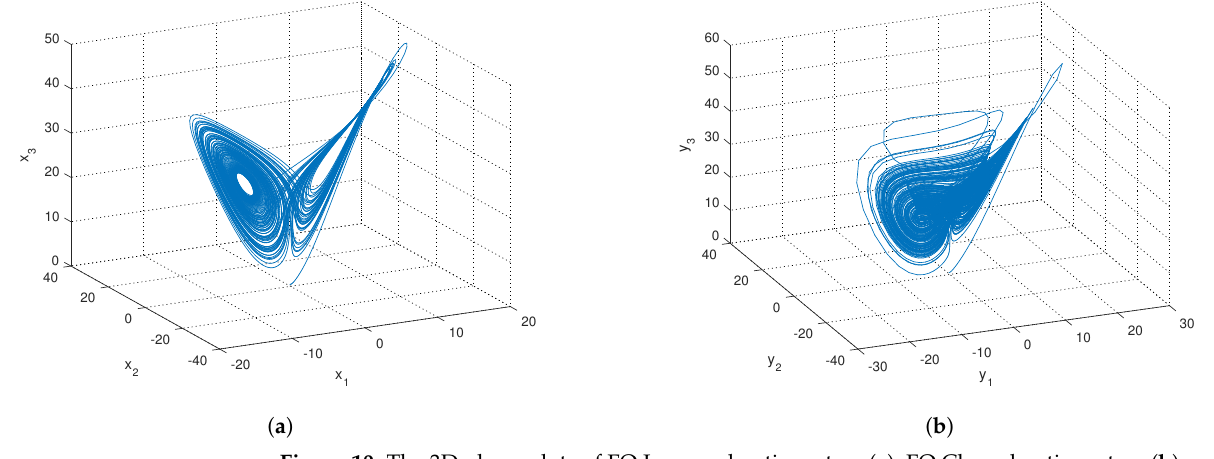
Figure 10. The 3D phase plots of FO Lorenz chaotic system ( a ), FO Chen chaotic system ( b ).